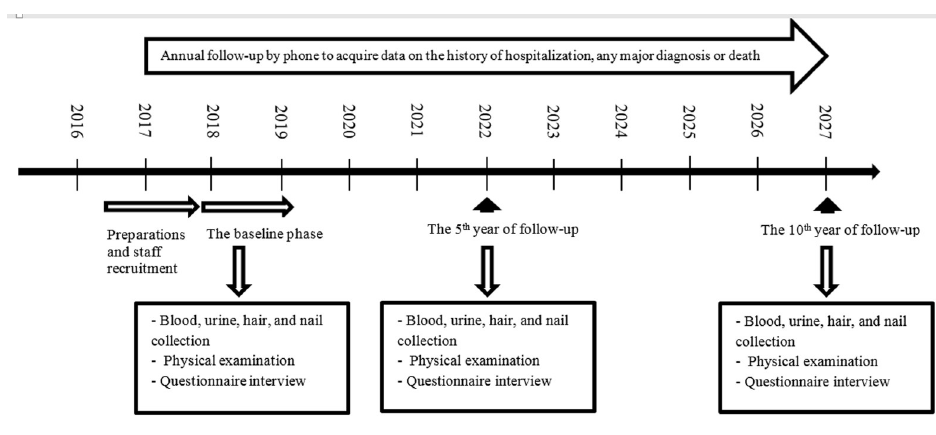
Fig 2. Flowchart of the